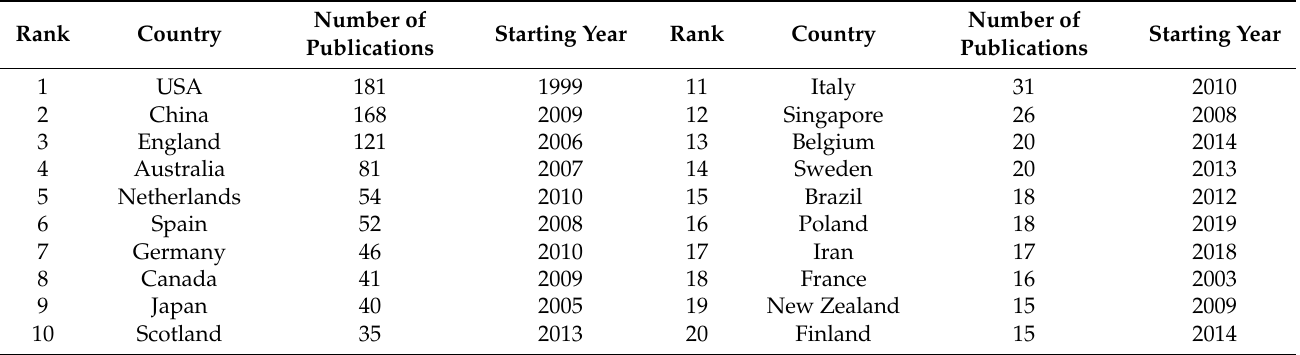
Table 1. Top 20 countries/regions with the most publications surrounding the study of green space and senior mental health.